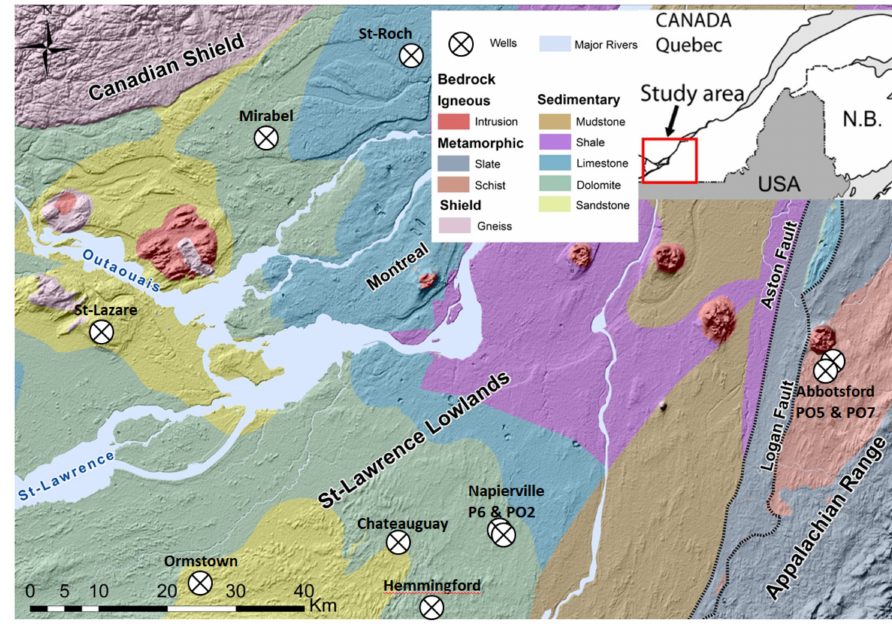
Figure 1. Geological map of the investigated area, with localization of the